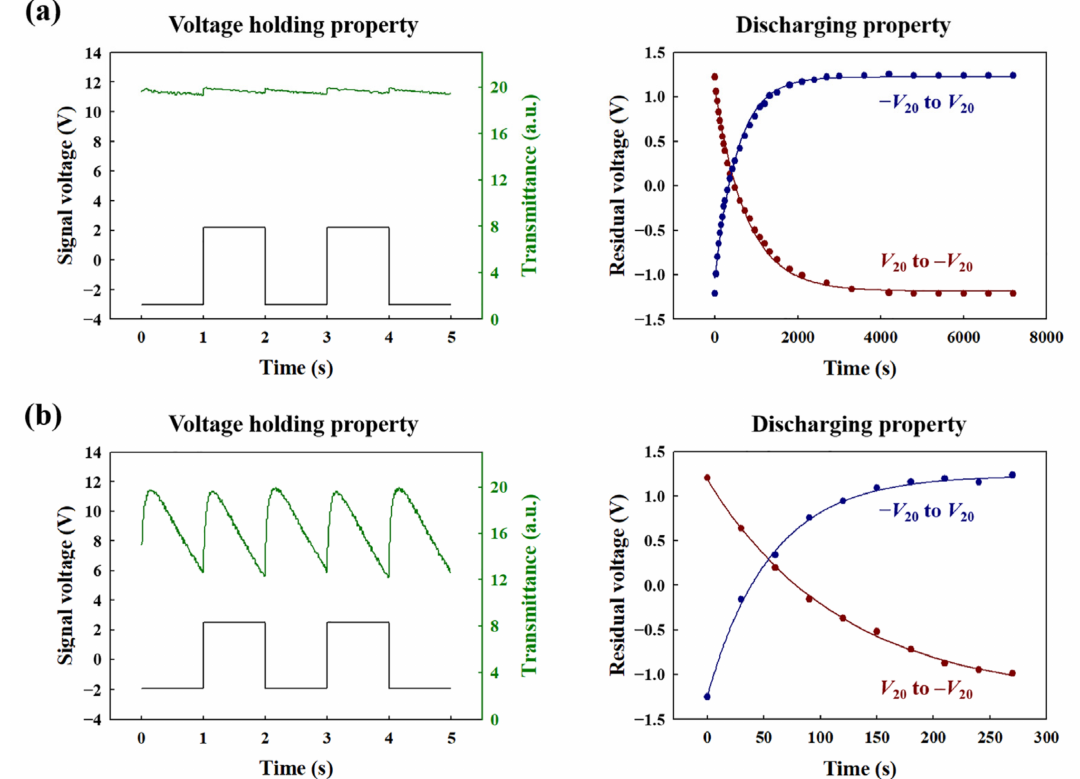
Figure 3. Temporal transmittance and residual voltage curves of the FFS n -LC mode according to the resistivity levels of LC alignment PI layers: ( a ) high-resistivity PI ( ρ ~ 10 15 Ω · cm) and ( b ) low-resistivity PI ( ρ ~ 10 13 Ω ·